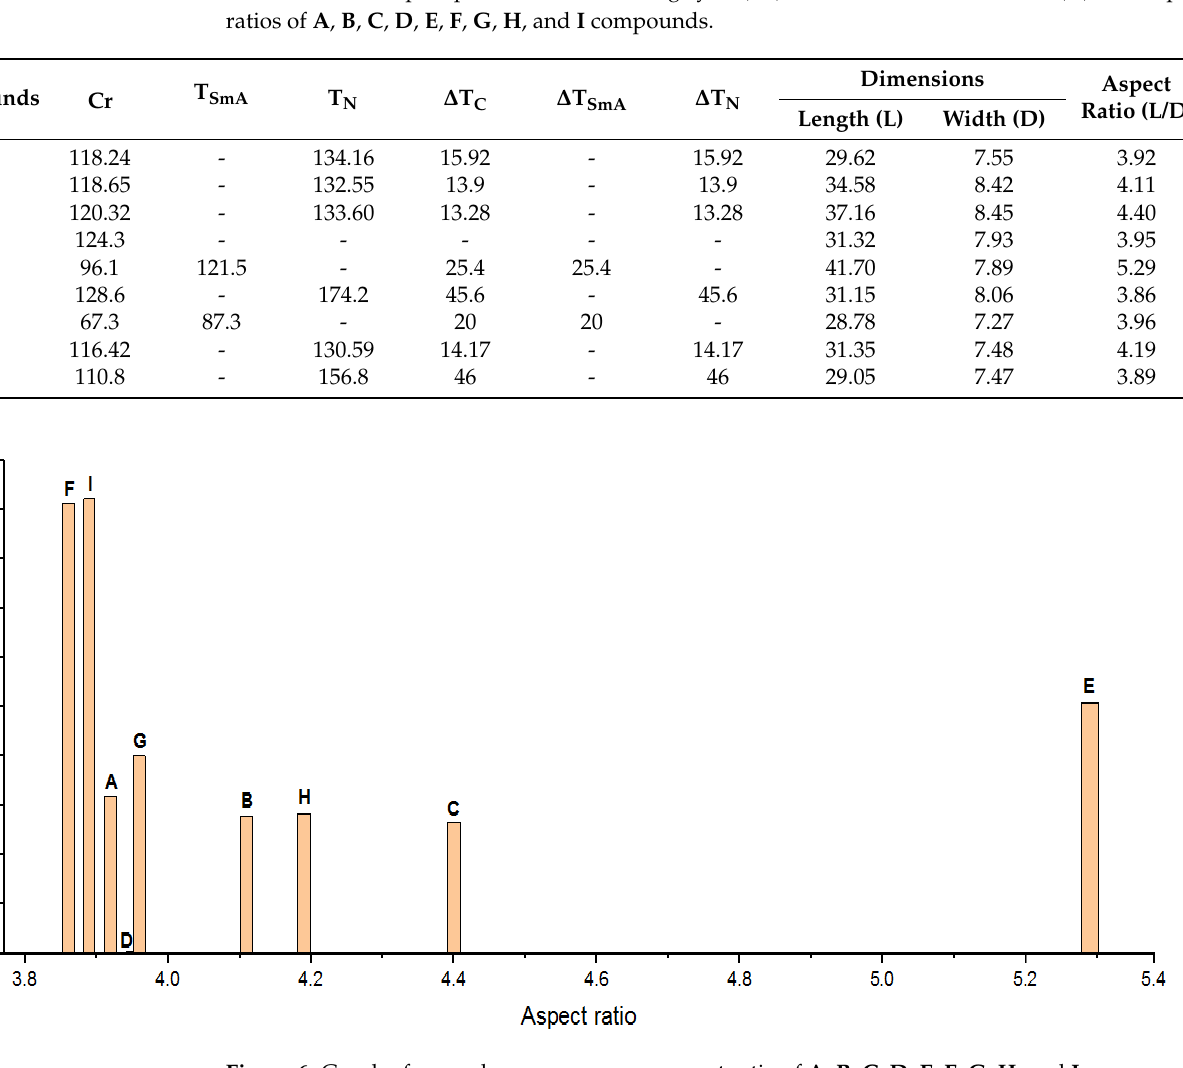
Figure 6. Graph of mesophase range versus aspect ratio of A , B , C , D , E , F , G , H , and I